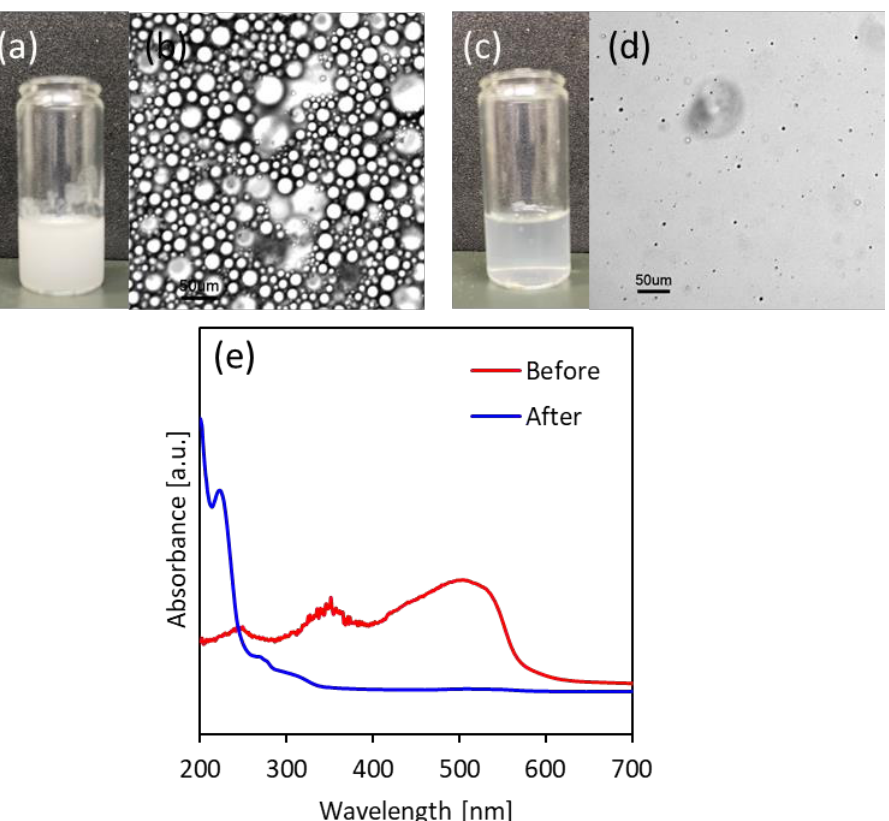
Figure 5. Separation of stabilized emulsion by using pTrim cryogel particles. Before separation of ( a ) photograph of the emulsion in bulk scale and ( b ) optical microscope image, and after separation of ( c ) photograph of the emulsion in bulk scale and ( d ) optical microscope image. ( e ) UV-vis spectra of emulsion.